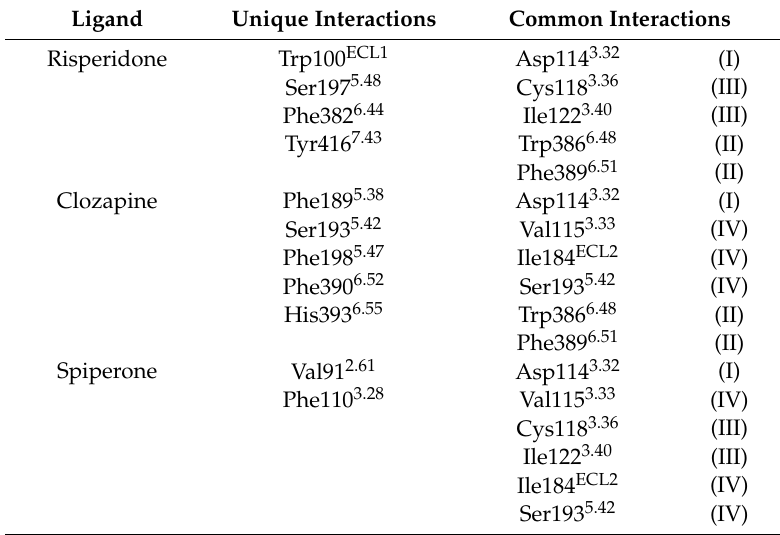
Table 1. Protein–ligand interactions (<3.5 Å) of co-crystallized risperidone, and stably bound clozapine and spiperone during MD simulations. (i) Common residues in contact between all ligands; (ii) common residues in contact between risperidone and clozapine; (iii) common residues in contact between risperidone and spiperone; (iv) common residues in contact between clozapine and spiperone. Ligand Unique Interactions Common Interactions Risperidone Trp100 ECL1 Asp114 3.32 (I) Ser197 5.48 Cys118 3.36 (III) Phe382 6.44 Ile122 3.40 (III) Tyr416 7.43 Trp386 6.48 (II) Phe389 6.51 (II) Clozapine Phe189 5.38 Asp114 3.32 (I) Ser193 5.42 Val115 3.33 (IV) Phe198 5.47 Ile184 ECL2 (IV) Phe390 6.52 Ser193 5.42 (IV) His393 6.55 Trp386 6.48 Phe389 6.51 (II) Spiperone Val91 2.61 Asp114 3.32 (I) Phe110 3.28 Val115 3.33 Cys118 3.36 Ile122 3.40 Ile184 ECL2 (IV) Ser193 5.42